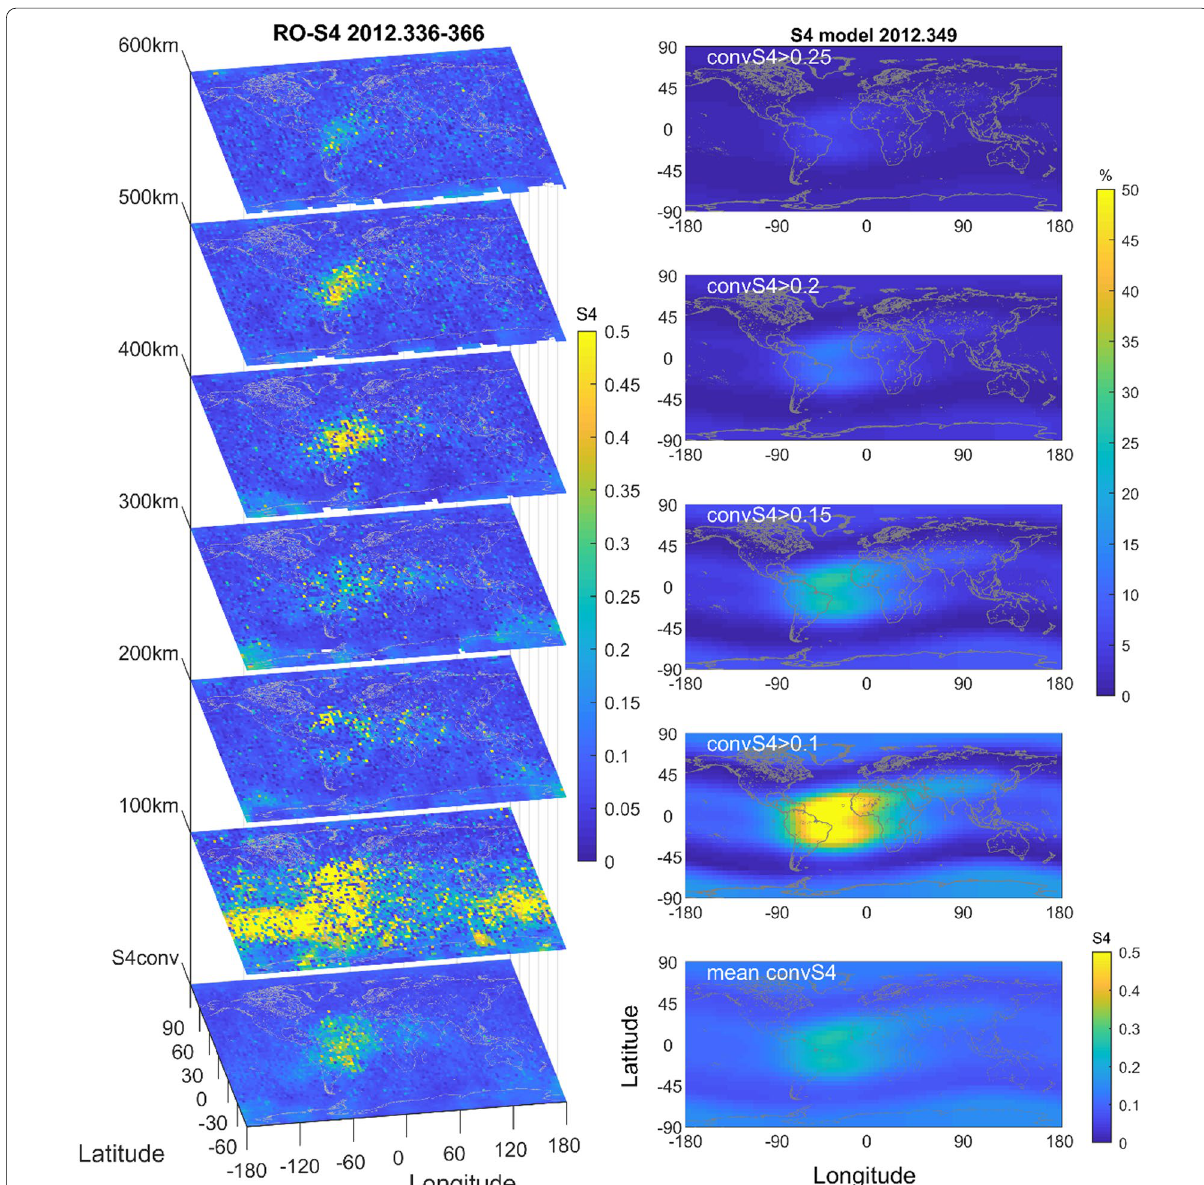
Fig. 17 The S4 index at various altitudes during December of 2012 and the occurrence probability of the S4 index on the ground over a certain threshold predicated on 13 December 2012. The model horizontal grid size is 3°